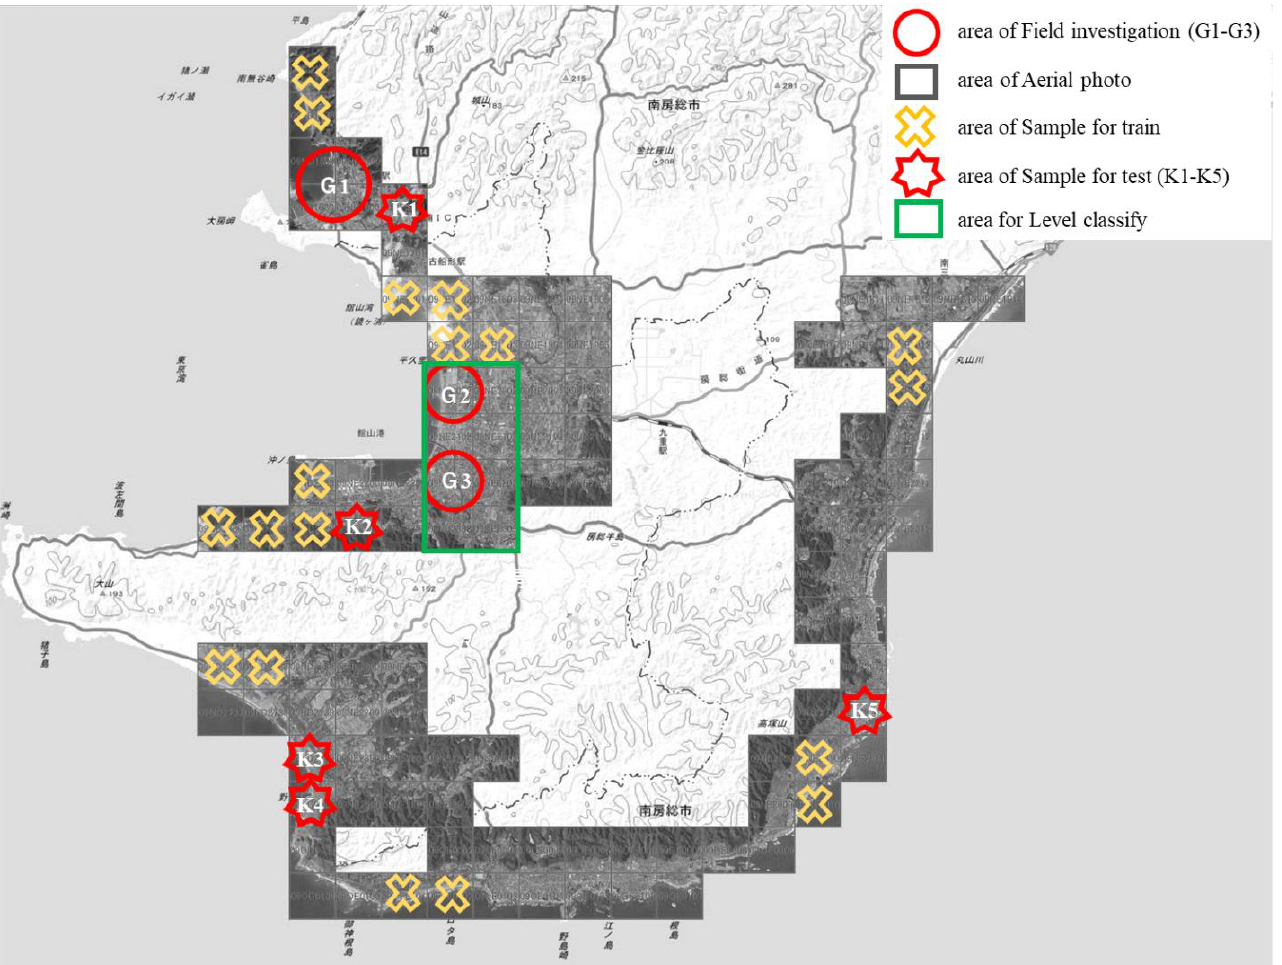
Figure 3. Aerial photo used (southern part of Chiba prefecture). G1 is a part of Minamiboso city, and G2 and G3 are parts of Tateyama city. K1 – K5 with red seven-point star is the area used for testing the accuracy of the trained model.